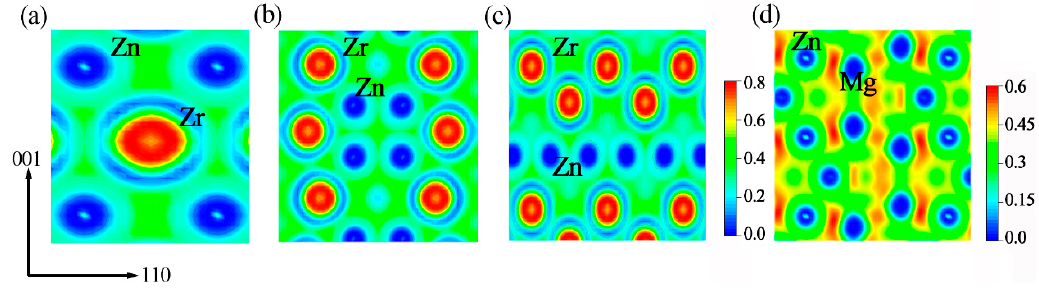
Figure 3. The contour line diagrams of the electron localization function (ELF) electronic distributions for Zn-Zr and MgZn 2 intermetallic compounds on the (110) plane—namely, ZnZr ( a ), Zn 2 Zr ( b ), Zn 2 Zr 3 ( c ), and MgZn 2 ( d ). The interval between the two nearest contour lines is 0.2 and 0.15 for the two systems, respectively.